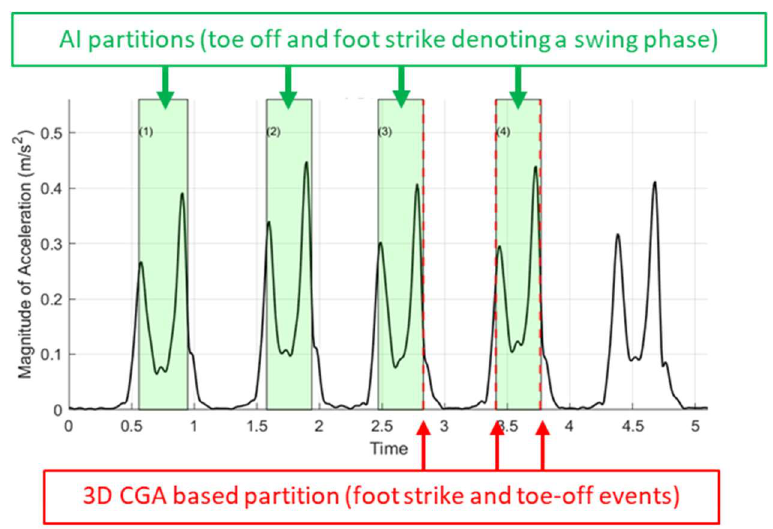
Figure 2. Sample IMU accelerometer signal and AI-based swing phase partitions (green shaded areas) of four out of five gait cycles. The user feedback from the GUI (Figure 1) was used to partition all datasets not included in training. Unshaded areas represent stance phases. Laboratory-based timings of foot-contact and foot-off events (red arrows) were used as ground truth to compute the partitioning error.